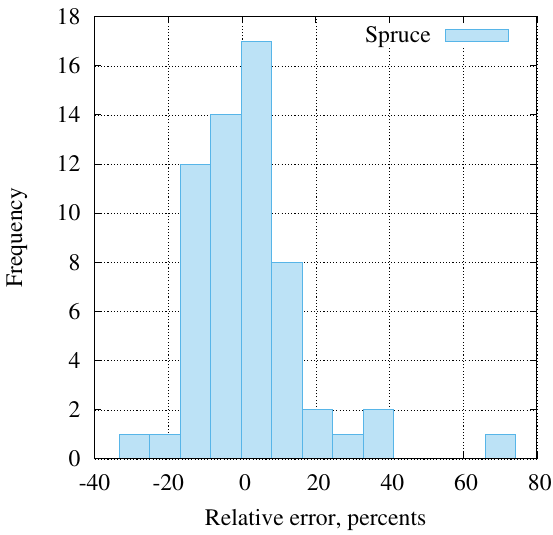
Figure 7. Relative errors of simulated spectra, spruce stands.